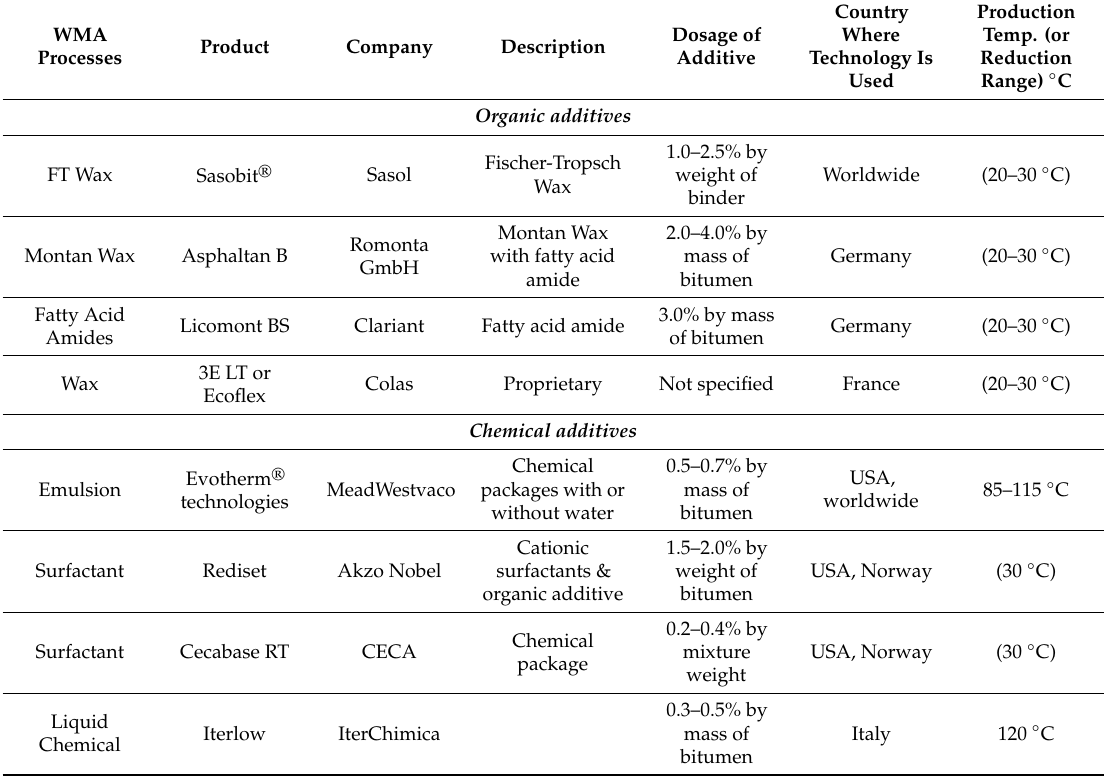
Table 1. Products used in Warm Mix technology. Reprinted with permission from [9]. Copyright (2011), with permission from